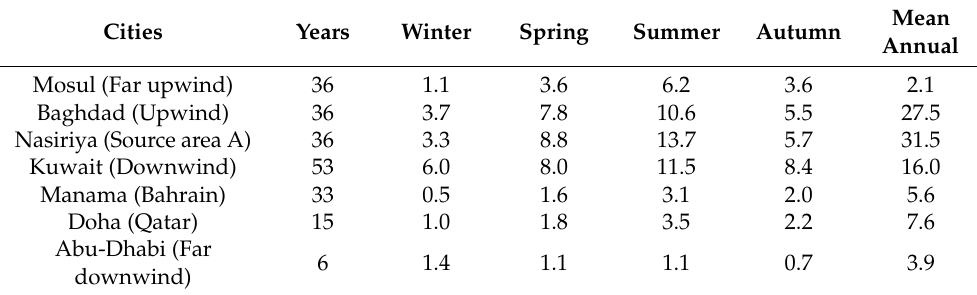
Figure 9. The two SDS hotspots’ contribution percentages in the Middle East as a single source or combined with other sources (2003 – 2021).